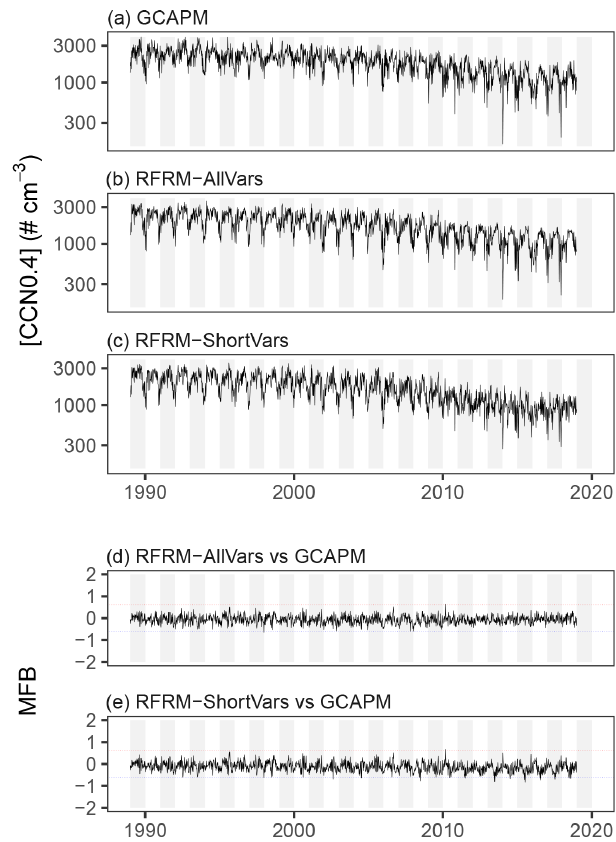
Figure 10. Time series (weekly-aggregated) for the surface 2 ◦ × 2 . 5 ◦ GCAPM grid box containing the SGP site – (a) GCAPM simulated, (b) RFRM-AllVars, and (c) RFRM-ShortVars derived [CCN0.4] – and the mean fractional bias (MFB) of (d) RFRM- AllVars and (e) RFRM-ShortVars. Dotted lines show the good agreement range of | MFB | < 0 . 6. Table 4. RFRM predictors for [CCN0.4] as listed in Table 2. Ital- icized text shows those predictors determined (in Sect. 3.2) to not strongly impact RFRM prediction of [CCN0.4]. Bold text shows the absence of their hourly